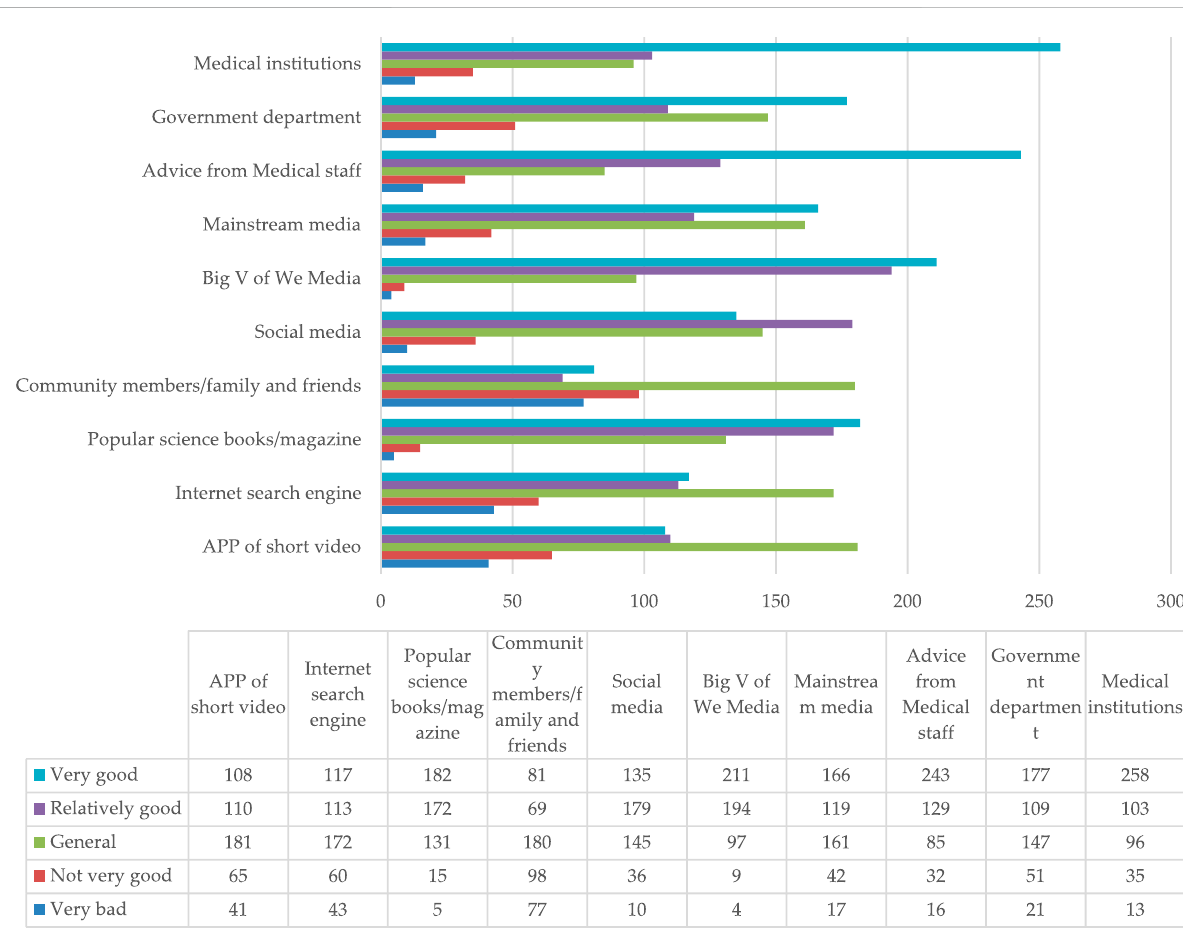
FIGURE 5 Overall quality of knowledge regarding the safe usage of children ’ s medication obtained from various